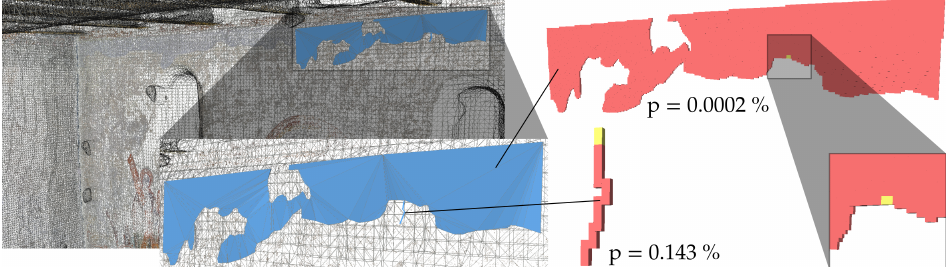
Figure 13. Percentage of overlapping voxels (yellow, d v = 0.5cm, r v = 1) for two near damage annotations (blue) that are not assigned, whereas a bounding box or distance check would result in a valid